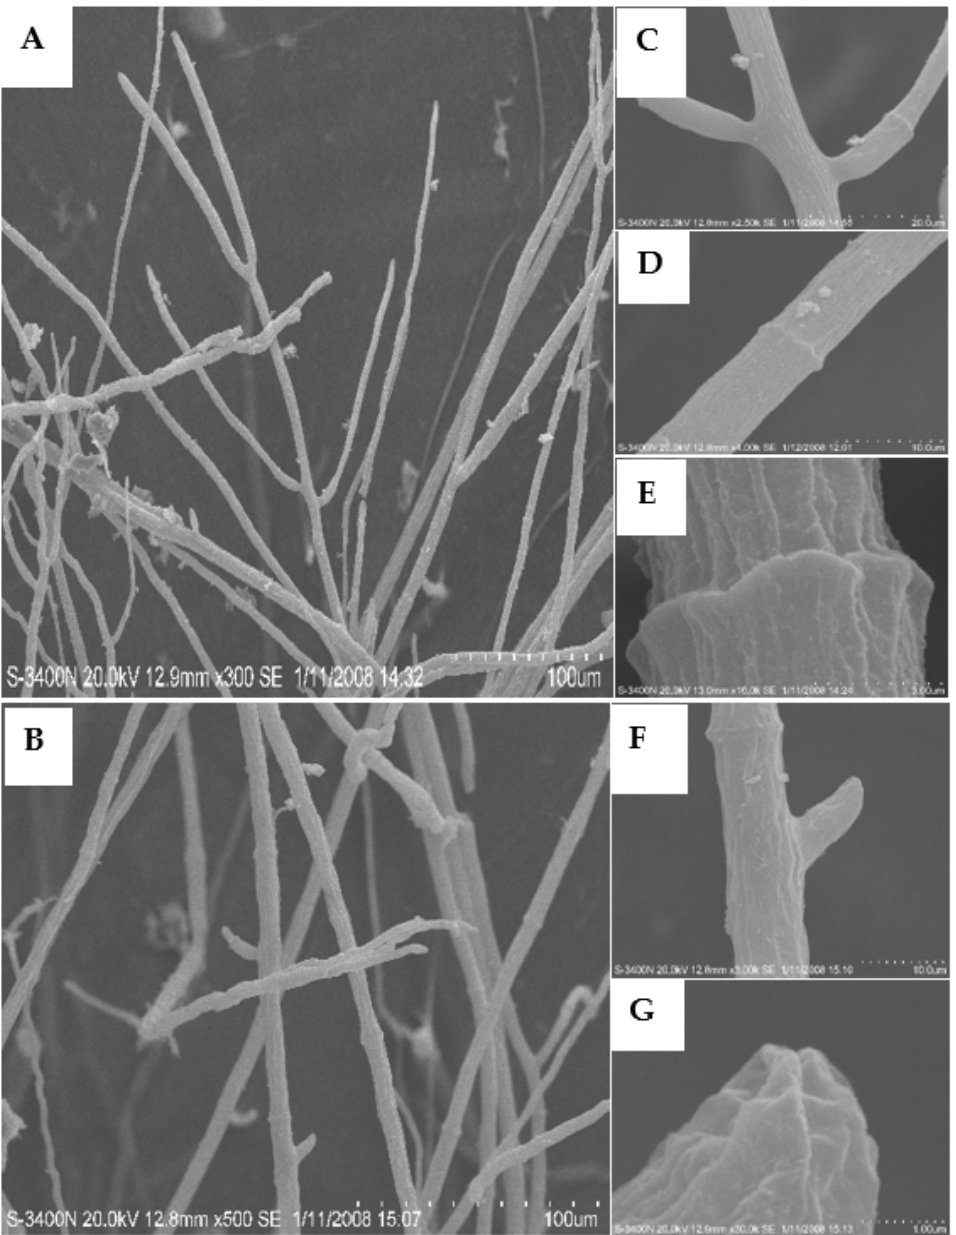
Figure 2. Scanning electron micrographs (SEM) of the hyphae from the colony of B. cinerea grown on PDA medium in the absence of L13 (control). Scale bars: ( A , B ) 100.0 µ m; ( C ) 20.0 µ m; ( D , F ) 10.0 µ m; ( E ) 3.0 µ m; ( G ) 1.0 µ m.